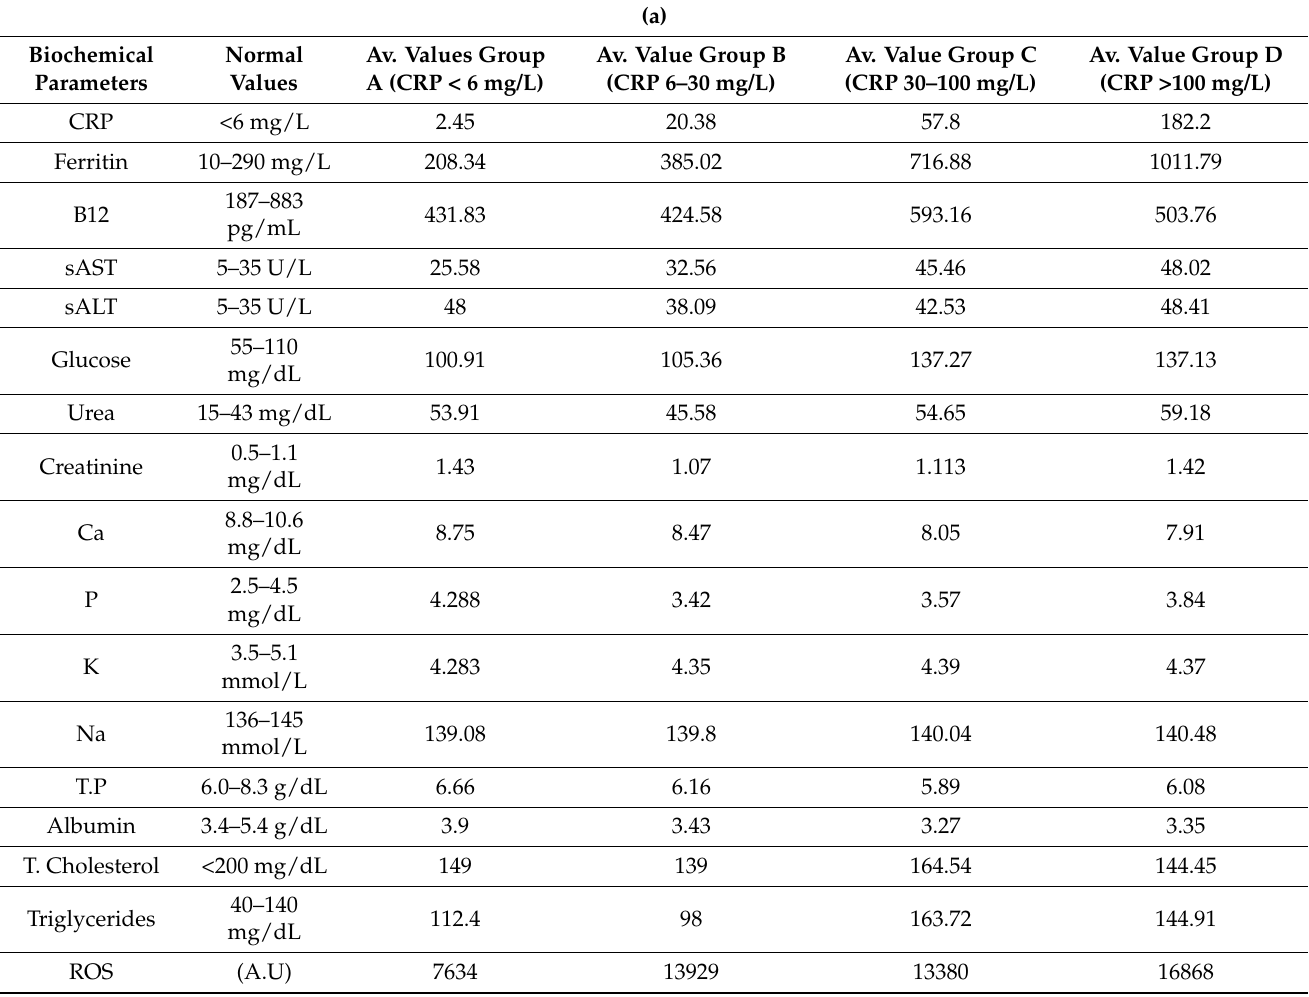
Table 4. (a) Biochemical parameters according to CRP values; (b) p - value between groups.